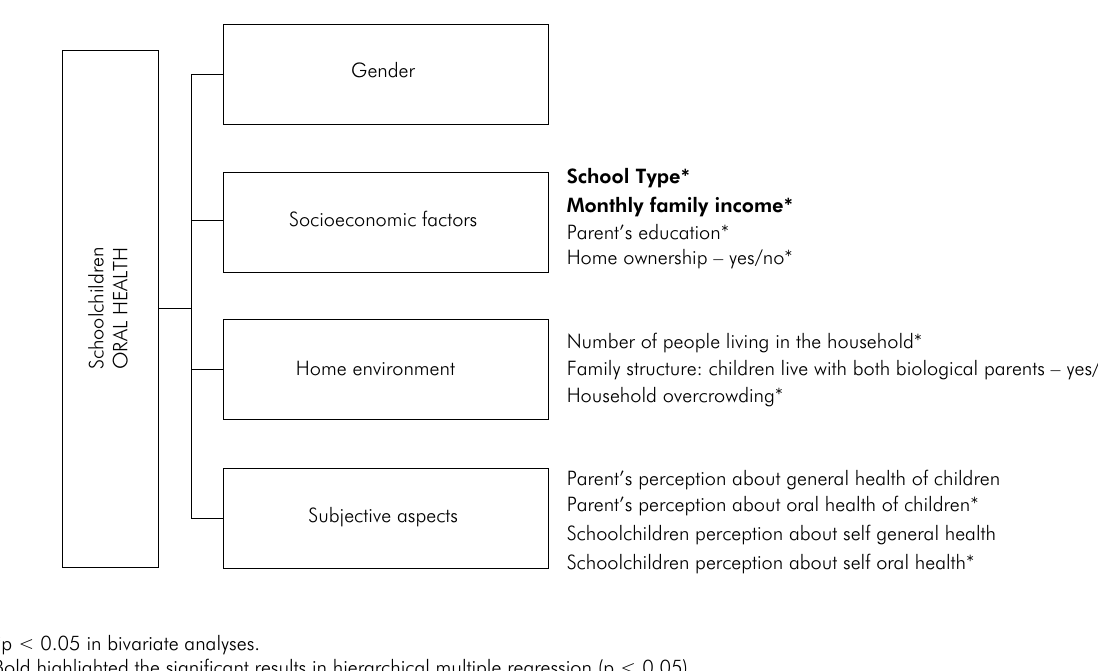
Figure. Theoretical model adopted in the